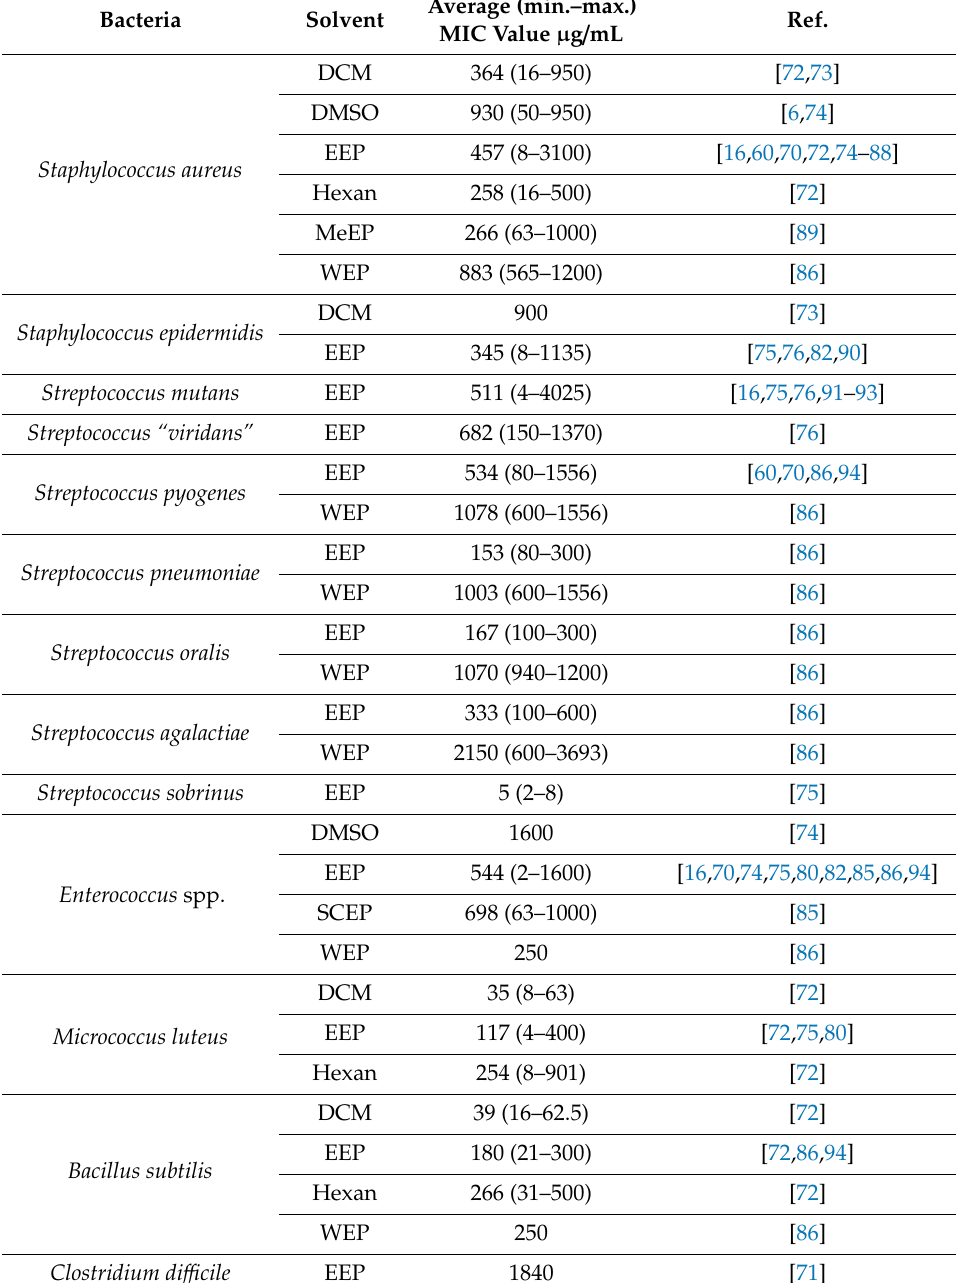
Table 1. The activity of di ff erent propolis’ extracts against Gram-positive